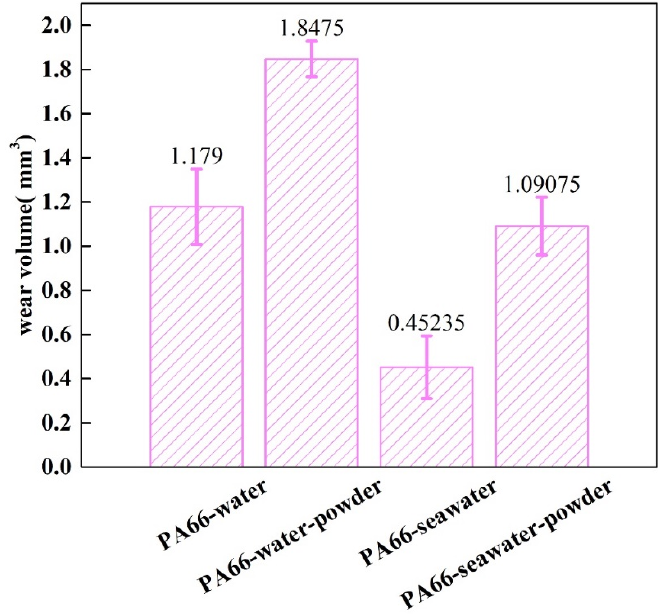
Figure 8. Wear amounts of PA66 pins tested using pin–disc friction and wear tester. The error bar in the Figure represents the standard deviation.